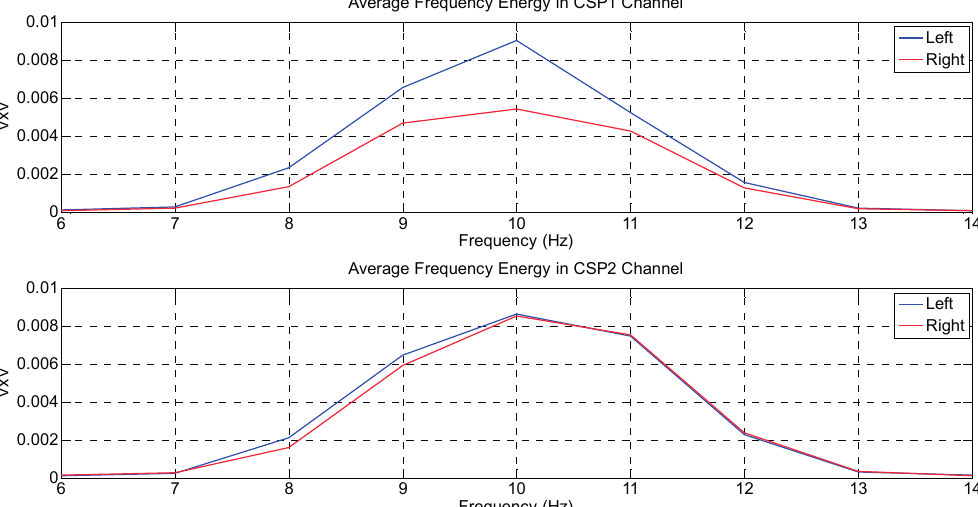
Figure 10. Average energy in the frequency domain for channels CSP1 and CSP2. CPS, common spatial